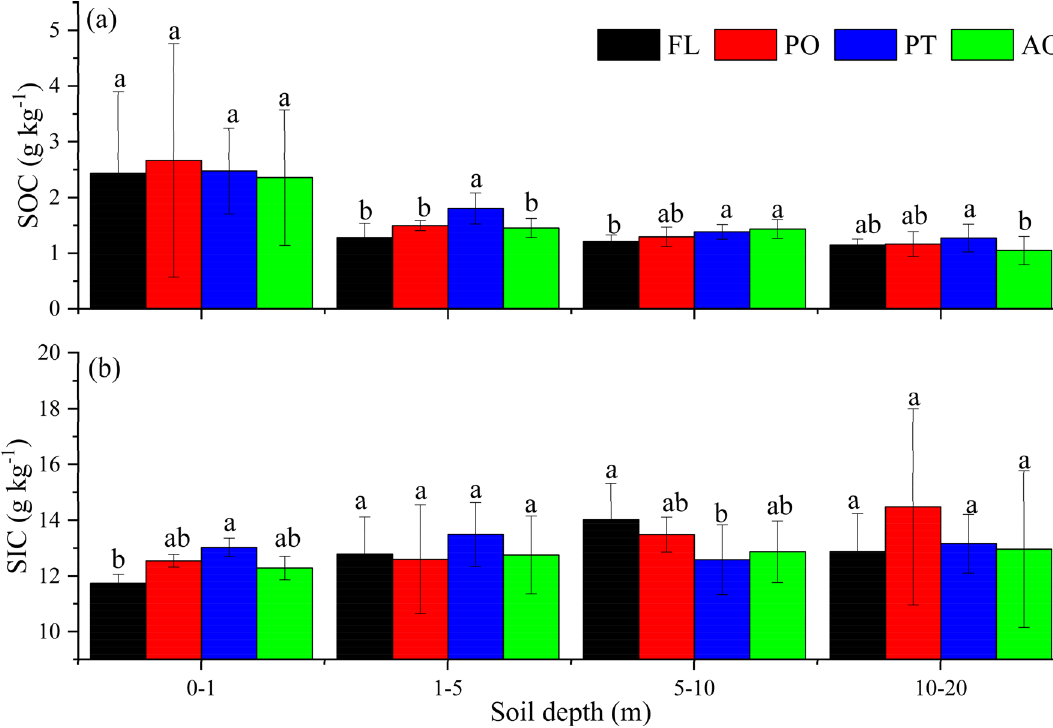
Figure 3. Average SOC ( a ) and SIC ( b ) content in 0–1 m, 1–5 m, 5–10 m and 10–20 m soil layers for different vegetation types. FL farmland, PO Platycladus orientalis (Linn.) Franco, PT Pinus tabulaeformis Carr., AO apple orchard. Bars are standard deviations. Different lower-case letters indicate significant differences at p < 0.05 among vegetation types within each layer.